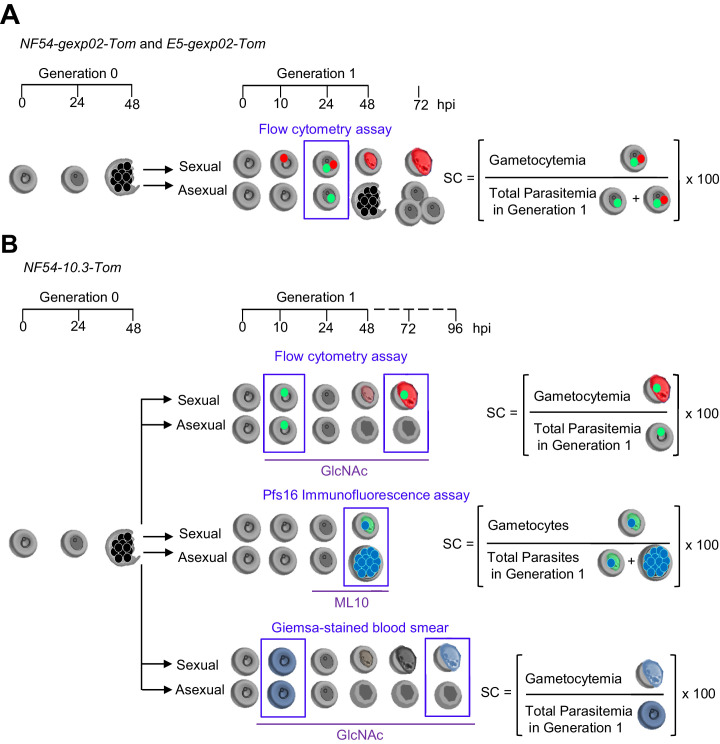
Schematic representation of the assays to determine sexual conversion rates.We used parasite lines expressing the fluorescent reporter tdTomato under the control of the gexp02 (A) or etramp10.3 (B) promoters. Generation 0 is the growth cycle at which the culture is exposed to different conditions (e.g., choline removal, or drugs), with parasite age indicated in h post-invasion (hpi). In all cases, the sexual conversion rate (SC) is calculated as the percentage of Generation 1 parasites that develop into non-replicative sexual forms (gametocytes). The total parasitemia (sexual + asexual parasites) at Generation 1 is measured by flow cytometry using fluorescent markers that stain DNA in all parasites (green dots) or active mitochondria in viable parasites (not represented here), by immunofluorescence assay using a fluorescent DNA stain (blue dots) or by light microscopy using Giemsa-stained smears (pale blue marks). Gametocytemia is measured by flow cytometry based on tdTomato signal (red marks), by immunofluorescence based on Pfs16 signal (pale green marks), or by light microscopy using Giemsa-stained smears (gametocyte-shaped pale blue marks). In immunofluorescence assays, the number of parasites and gametocytes in a given number of fields is determined instead of parasitemia and gametocytemia, but since both total parasites and gametocytes are determined simultaneously from the same samples (i.e., the total erythrocytes denominator is the same for both parameters), this does not affect the sexual conversion rate calculation. Detection of gametocytes based on tdTomato expression in the NF54-gexp02-Tom and E5-gexp02-Tom lines is performed as early as 24 hpi in Generation 1. Detection based on Pfs16 expression is performed at 48 hpi, and requires addition of ML10 to prevent schizont bursting and reinvasion, which would increase the number of asexual parasites observed. Detection of gametocytes based on tdTomato expression or light microscopy analysis of Giemsa-stained smears in the NF54-10.3-Tom line is performed at 72 or 96 hpi, respectively, and requires the addition of N-acetyl-D-glucosamine (GlcNAc) to prevent multiplication of asexual parasites, which would collapse the culture.